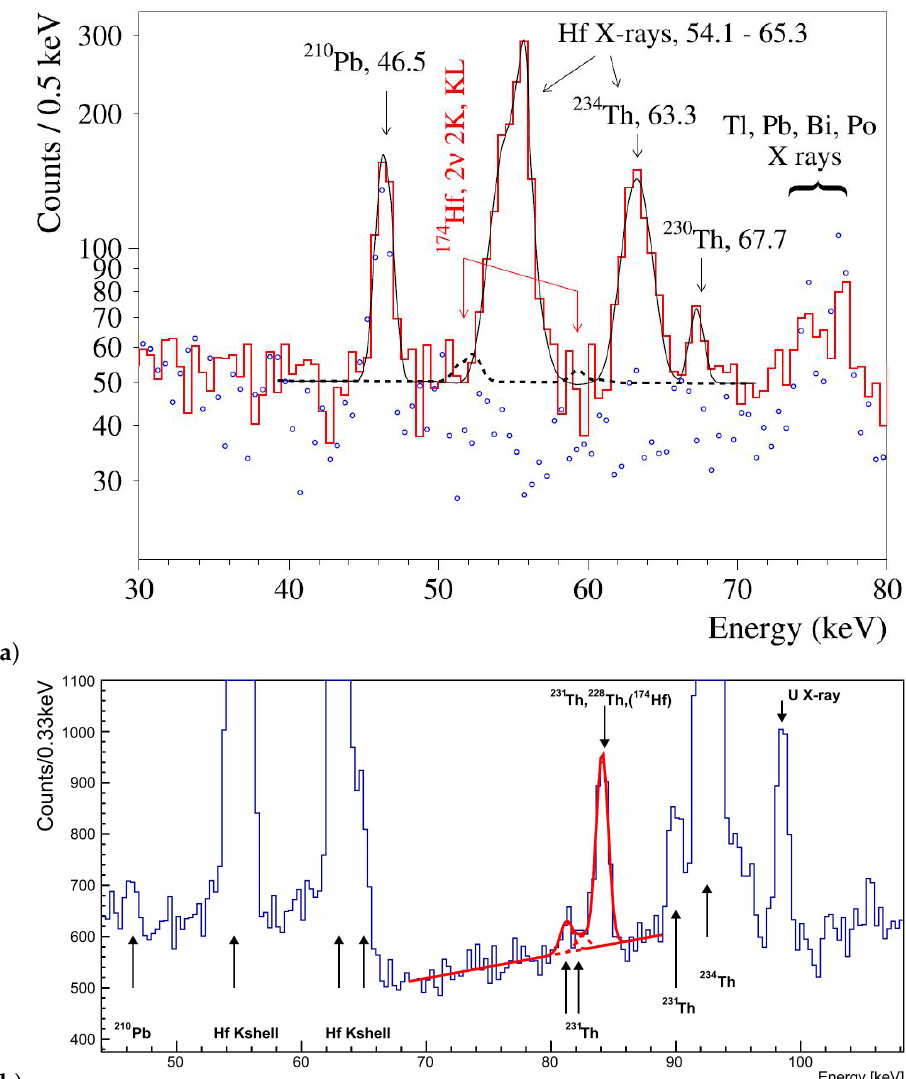
Figure 3. ( a ) Energy spectrum acquired with the experiment at HADES [29] in the region of interest for the 2 ν 2K and 2 ν KL of 174 Hf (solid histogram, online red). The dots (online blue) is the background data without the Hf sample and normalized to the time of acquisition. Solid line (online black) is the fit of the background model, and the dashed line is the excluded effect. (Taken from Ref. [29] with permission). ( b ) Energy spectrum acquired with the experiment at LNGS [30], in the region of interest for the α decay of 174 Hf (see next section). However, the low energy range of the panel shows the energy region of interest for the case of 2 ν 2K and 2 ν KL of 174 Hf decay, where the dominant background is due to the Hf X-rays. The solid line (online red) is the background model for the α decay of 174 Hf and the dashed line is the excluded effect. (Taken from Ref. [30] with permission).